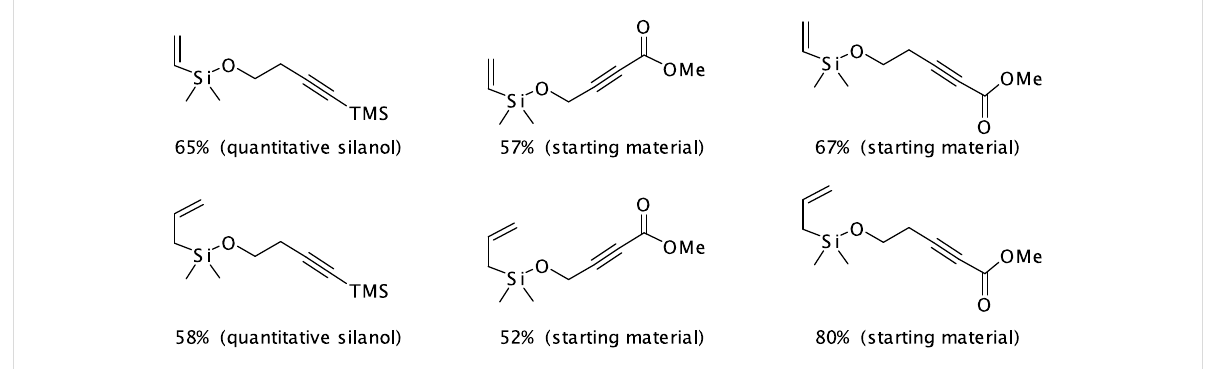
Figure 1: Functionalised acetylenes prepared and used in silyl ether-tethered Pauson-Khand reactions. Yields correspond to yield of the silyl ether formed, figures in brackets from the Pauson-Khand reaction.